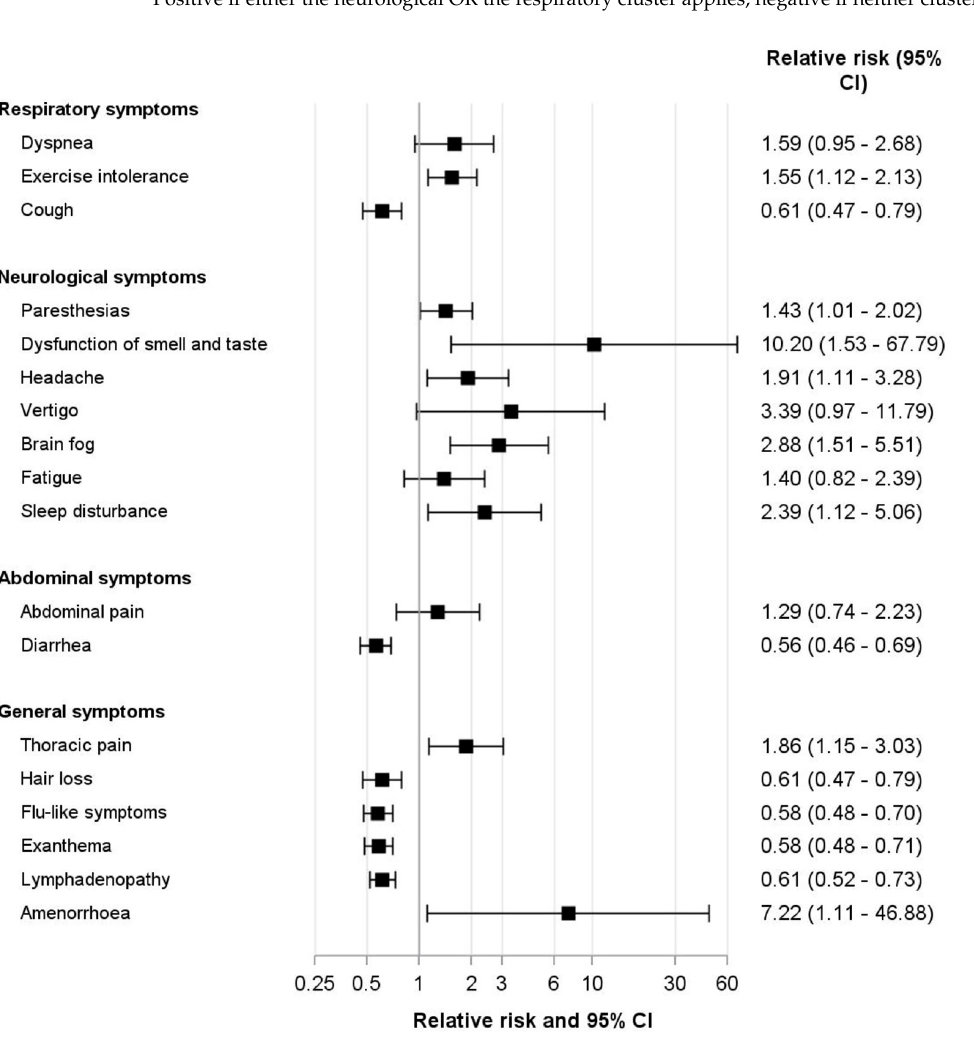
Table 4. Sensitivity, specificity, and predictive values to identify patients with LC versus alternative diseases from clinical symptom clusters in suspected pediatric Long COVID.